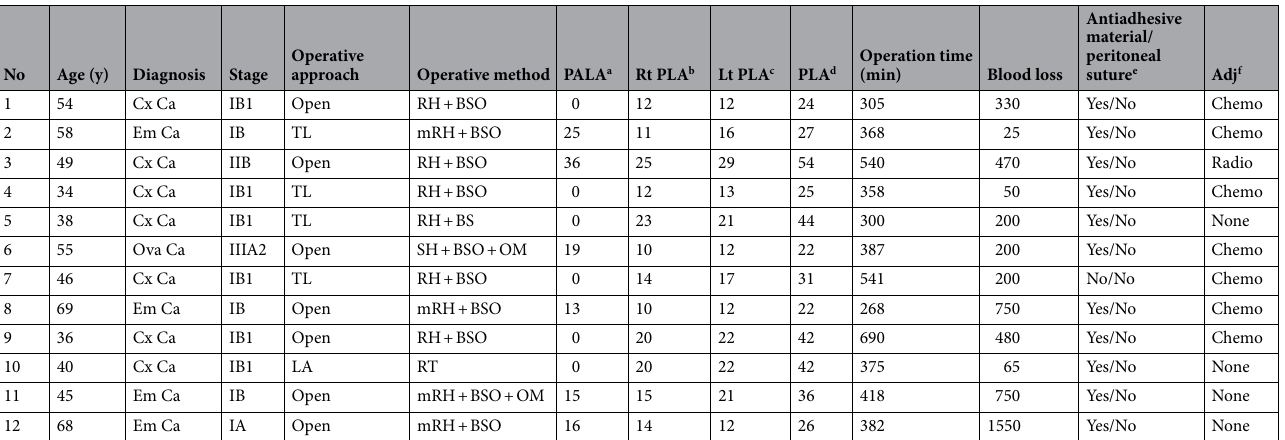
Table 4. Initial surgical characteristics in cases of postoperative IBSPP. Cx Ca, cervical cancer; Em Ca, endometrial cancer; Ova Ca, ovarian cancer; TL, total laparoscopic surgery; LA, laparoscopic-assisted surgery; RH, radical hysterectomy; BSO, bilateral salpingo-oophorectomy; SH, simple hysterectomy; mRH, modified radical hysterectomy; RT, radical trachelectomy; OM, omentectomy; a Number of lymph nodes removed by para-aortic lymph node dissection. b Number of lymph nodes removed by right pelvic lymph node dissection. c Number of lymph nodes removed by left pelvic lymph node dissection. d Total number of lymph nodes removed by pelvic lymph node dissection. e Is antiadhesive material affixed or sprayed onto a skeletonized pelvic structure after PLA?/Is the skeletonized pelvic structure after PLA closed using some techniques, such as peritoneal suture? f Adj, Adjuvant therapy after initial operation and before internal herniation.